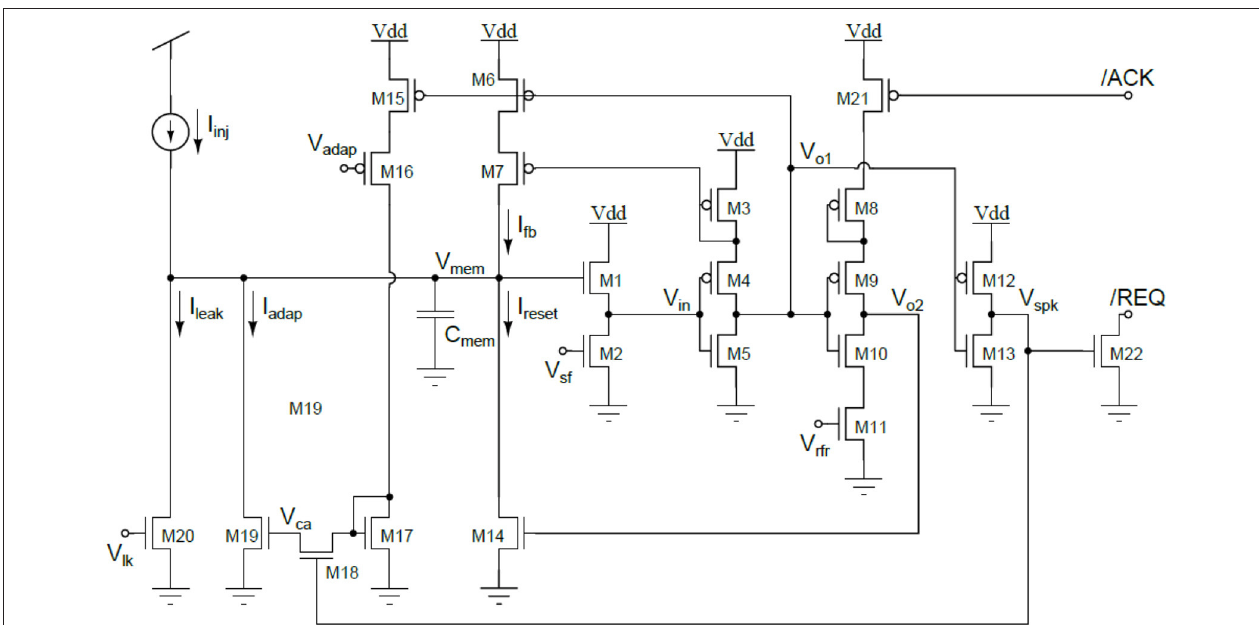
FIGURE 20 | Circuit diagram of the I&F neuron. The neuron’s membrane capacitor C mem integrates the input current I inj into the membrane voltage V mem . When V mem reaches the spiking threshold V spk the occurrence of a spike is signaled by the output voltage V spk , which quickly switches for zero to the power